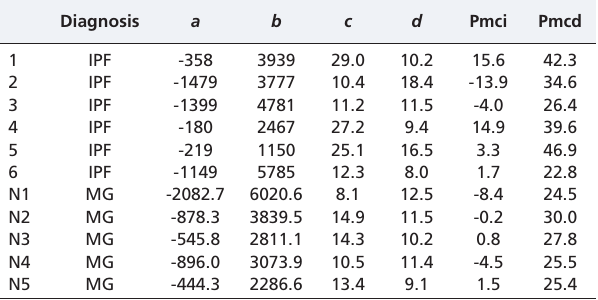
Table 4 - Individual results of the sigmoidal fit for patients and controls.